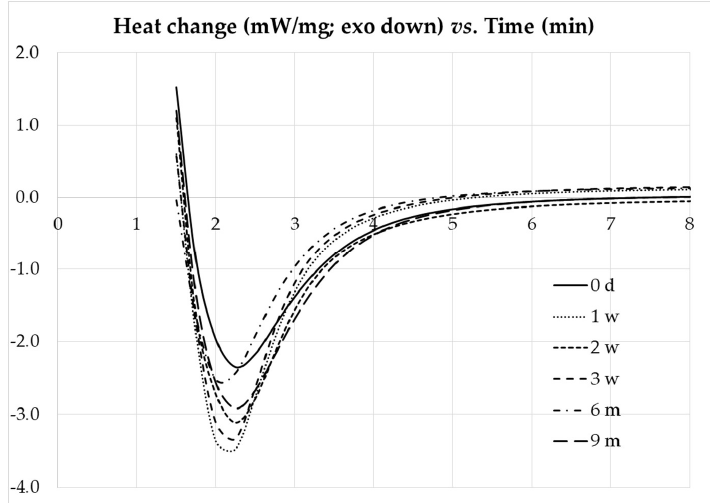
Figure 14. DSC isothermal profiles of composite with different storage times.